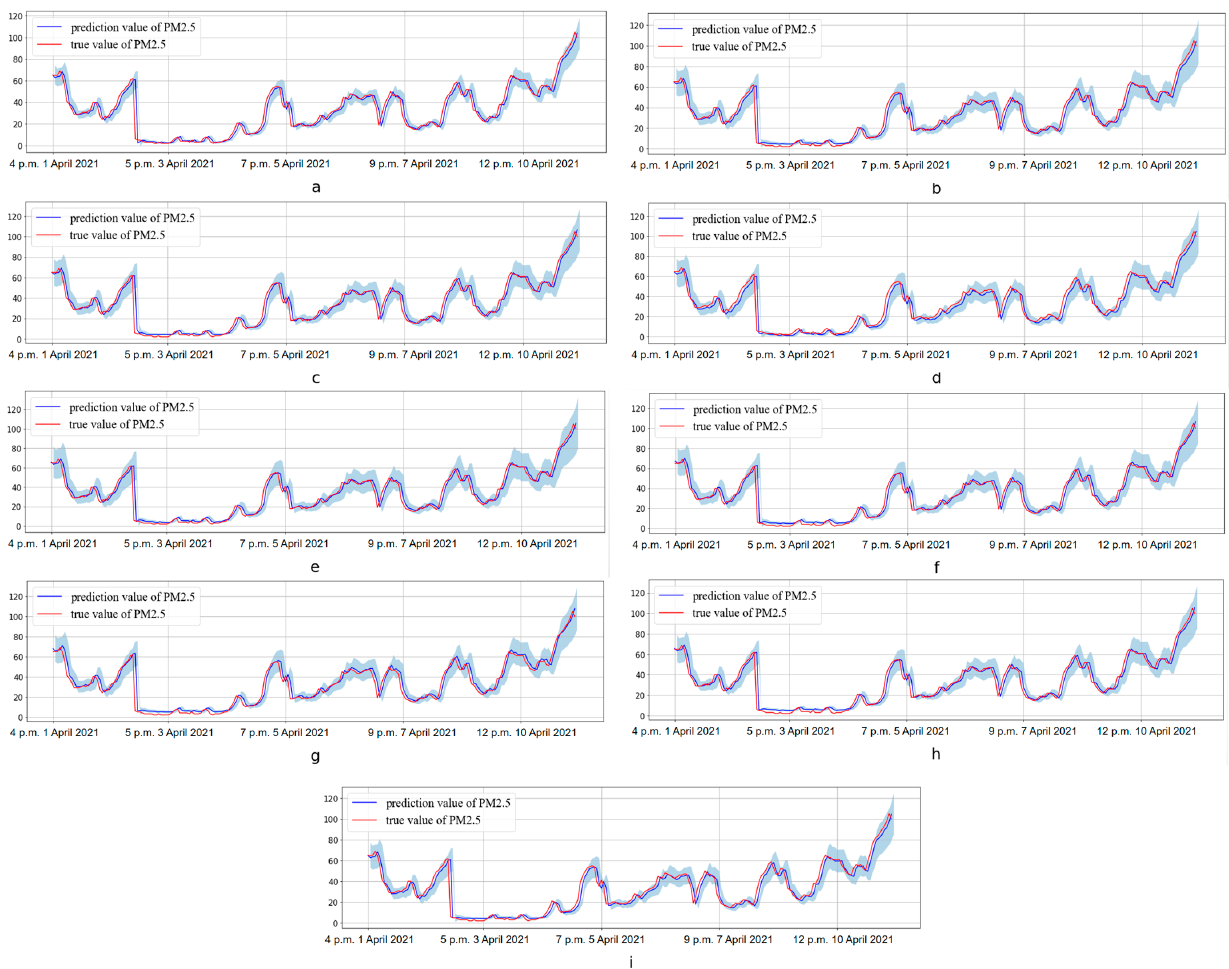
Figure 7. Point and interval prediction of PM2.5 concentration in Beijing. Subgraphs ( a – i ) represent the point and interval prediction result of BSSA–DeepAR, CASSA–DeepAR, CSSA–DeepAR, FOSSA–DeepAR, HSSA–DeepAR, ISSA–DeepAR, ISSA1–DeepAR, SSA–DeepAR, and DeepAR,